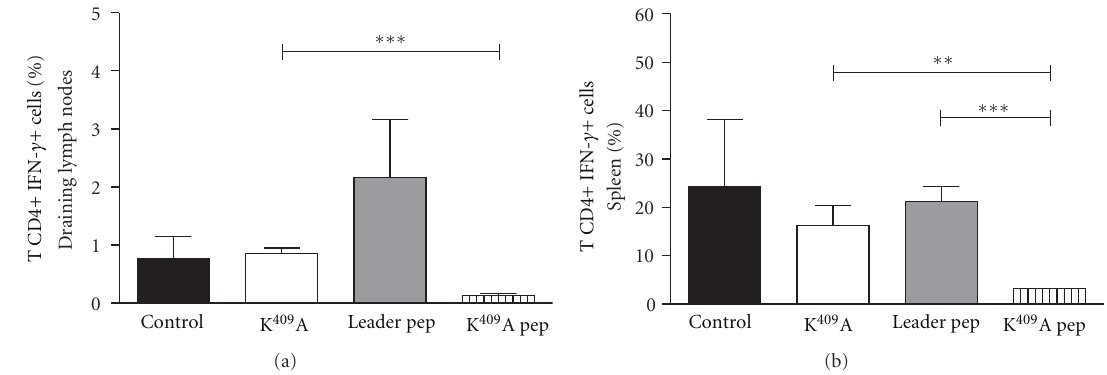
Figure 3: Expansion of CD4+IFN- γ + T cells in lymph nodes (a) and spleen (b) after K 409 A, Leader pep, and K 409 A pep inoculation. Cells from draining lymph nodes and spleen collected at day 21 after immunization were labeled with anti-CD4 monoclonal antibody, fixed and permeabilized, stained intracellularly, and analyzed by flow cytometry evaluating the CD4, IFN- expression. Results are expressed in mean and SD. ∗∗∗ P < 0 . 001: K 409 A versus K 409 A pep (A); ∗∗ P < 0 . 01: K 409 A versus K 409 A pep (B); ∗∗∗ P < 0 . 001: Leader pep versus K 409 A pep (B).